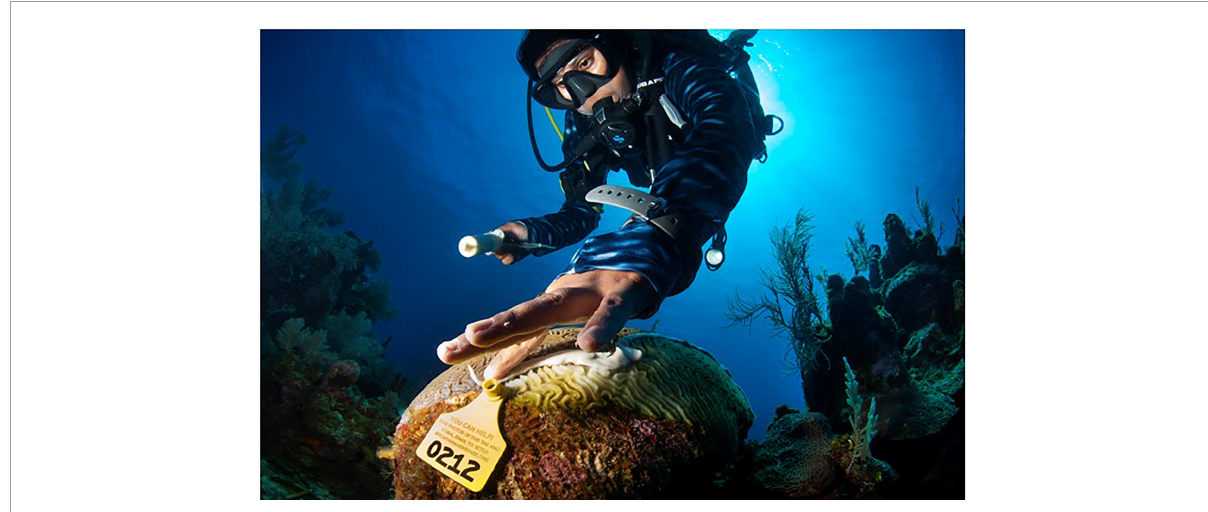
FIGURE 4 Roatan Marine Park staff treating an infected grooved brain coral with Base2b + amoxicillin. Photo credit: Antonio